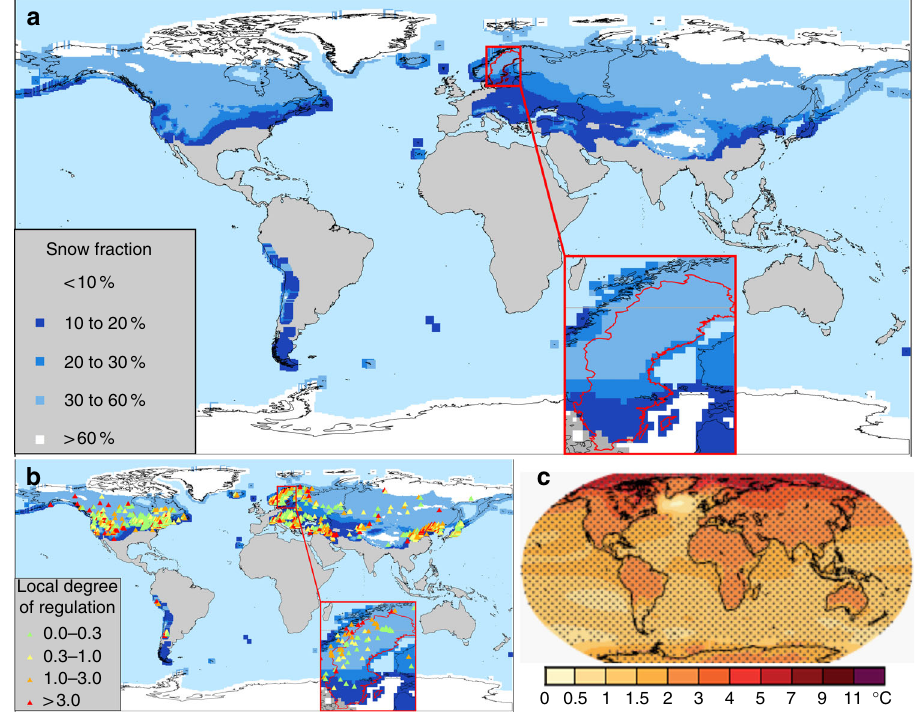
Fig. 2 Regions with similarities in snow, hydropower regulation and temperature change. Global regions with: a snow fraction in precipitation, b the degree of regulation in hydropower dams for these regions, and c global warming at RCP4.5 according to IPCC, Fig. 12.11 31 . Details are highlighted for